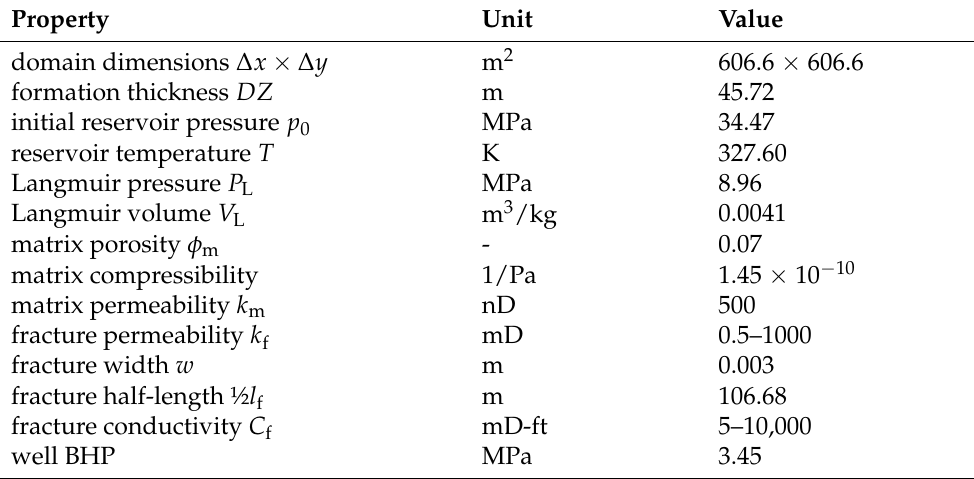
Table 3. Input data of the simulations for the comparison with CMG. BHP—bottom-hole pressure.